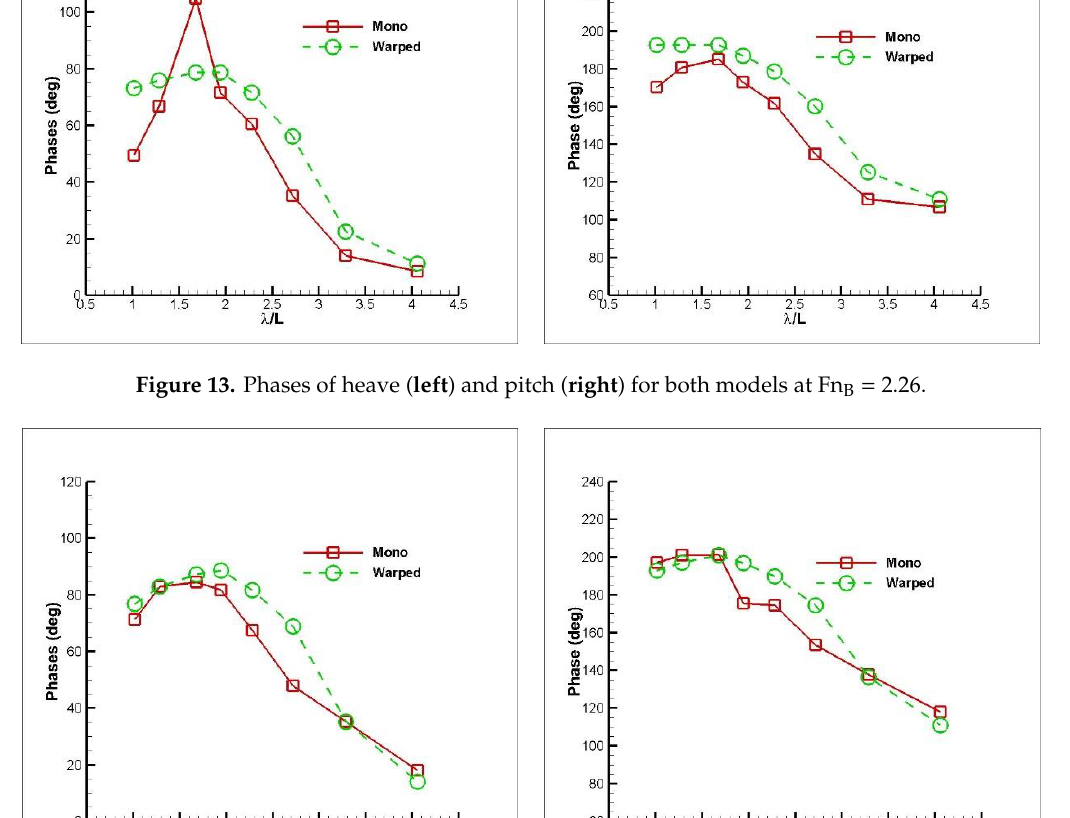
Figure 14. Phases of heave ( left ) and pitch ( right ) for both models at Fn B = 2.8.